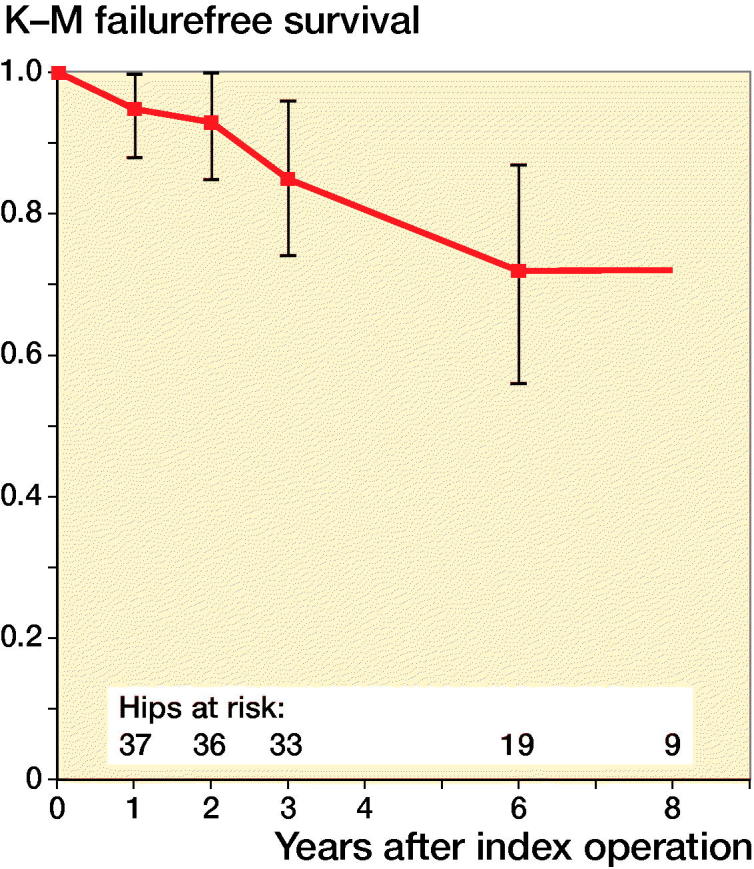
Kaplan–Meier survival plot (% survival with 95% confidence intervals) in all 39 hips, with time to failure (reoperation or MP ≥ 50%) as “survival”.